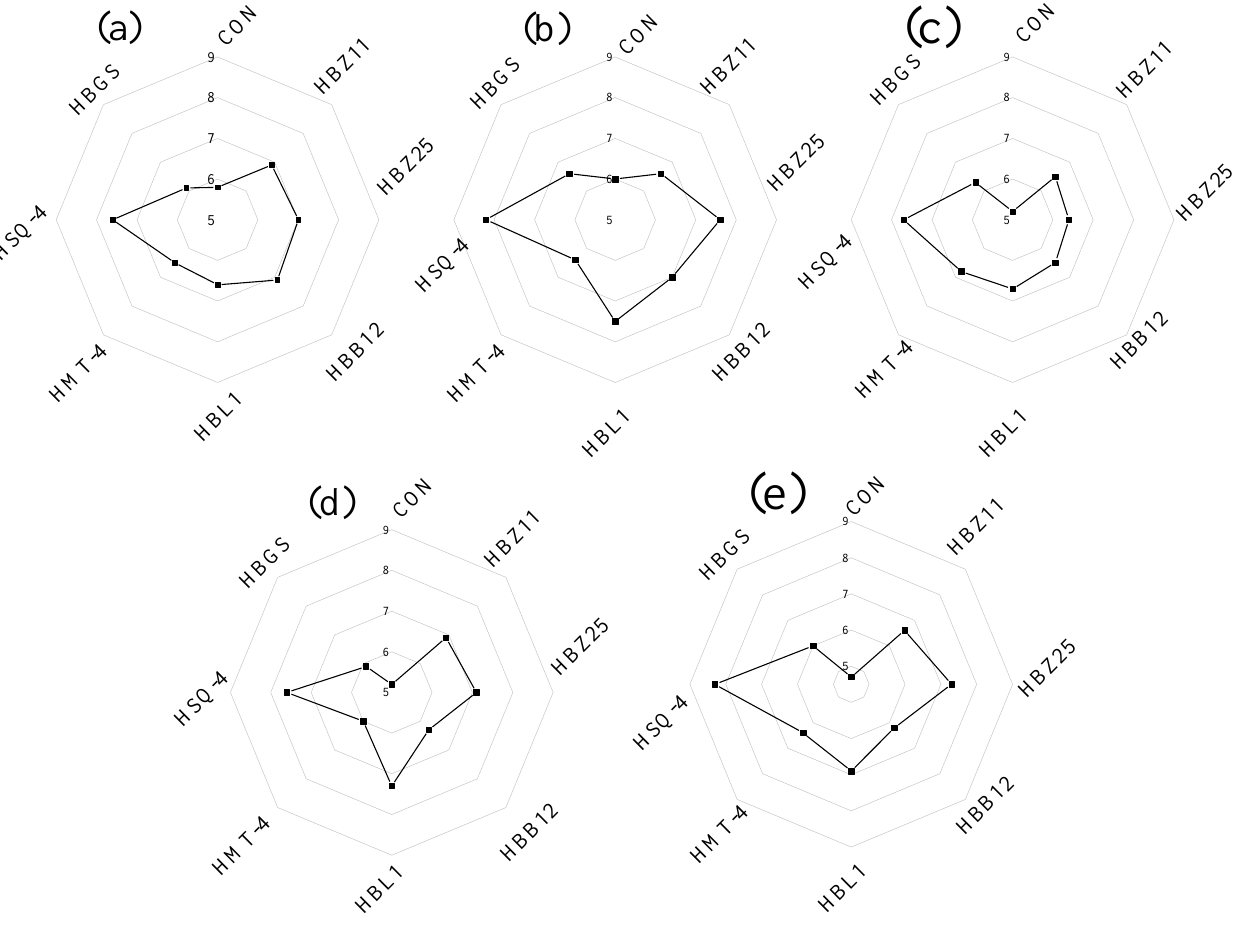
Figure 3. The sensory evaluation of the HST. ( a ) appearance; ( b ) texture; ( c ) flavor; ( d ) taste; ( e ) overall acceptability. CON indicated HST prepared by natural fermentation of pasteurized HST materials. HBZ11, HBZ25, HSQ-4, HMT-4, HBGS, HBL1, and HBB12 were HST prepared with starter cultures Bifidobacterium animalis subsp. lactis BZ11, Bifidobacterium animalis subsp. lactis BZ25, Lactiplantibacillus plantarum SQ-4, Lactiplantibacillus pentosus MT-4, Lactobacillus bulgaricus , Bifidobacterium longum BL1, and Bifidobacterium animalis subsp. lactis BB12,